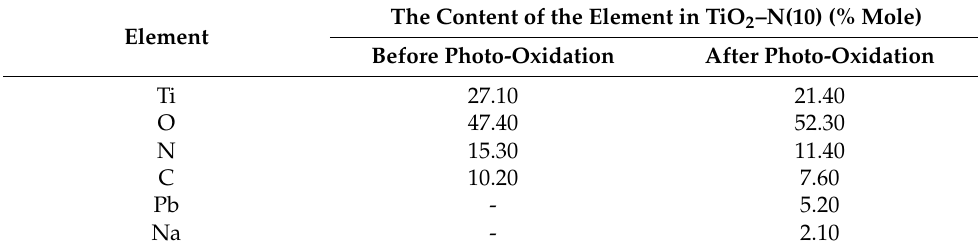
Table 2. The composition the doped photocatalyst based on the EDX data.